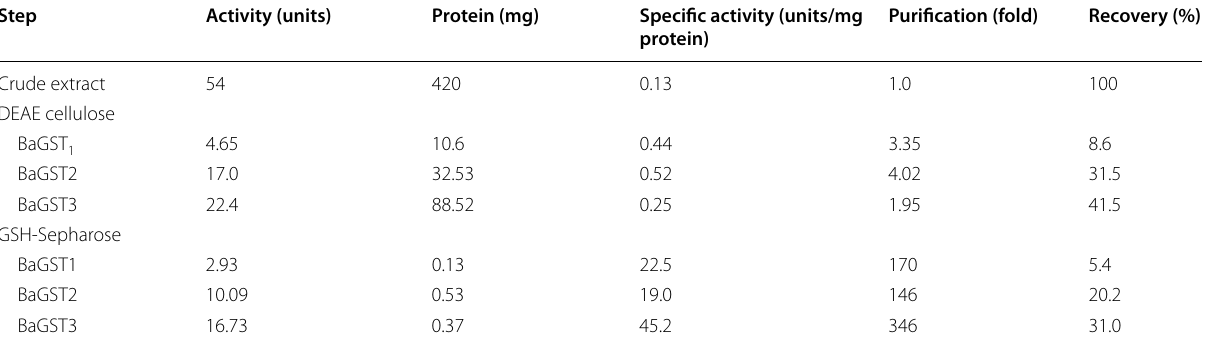
Table 1 Purification of GSTs from B. alexandrina